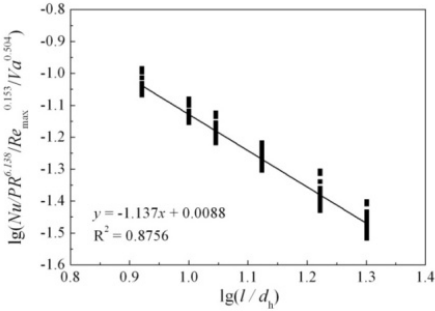
Figure 17. Determination of coefficients c and a .